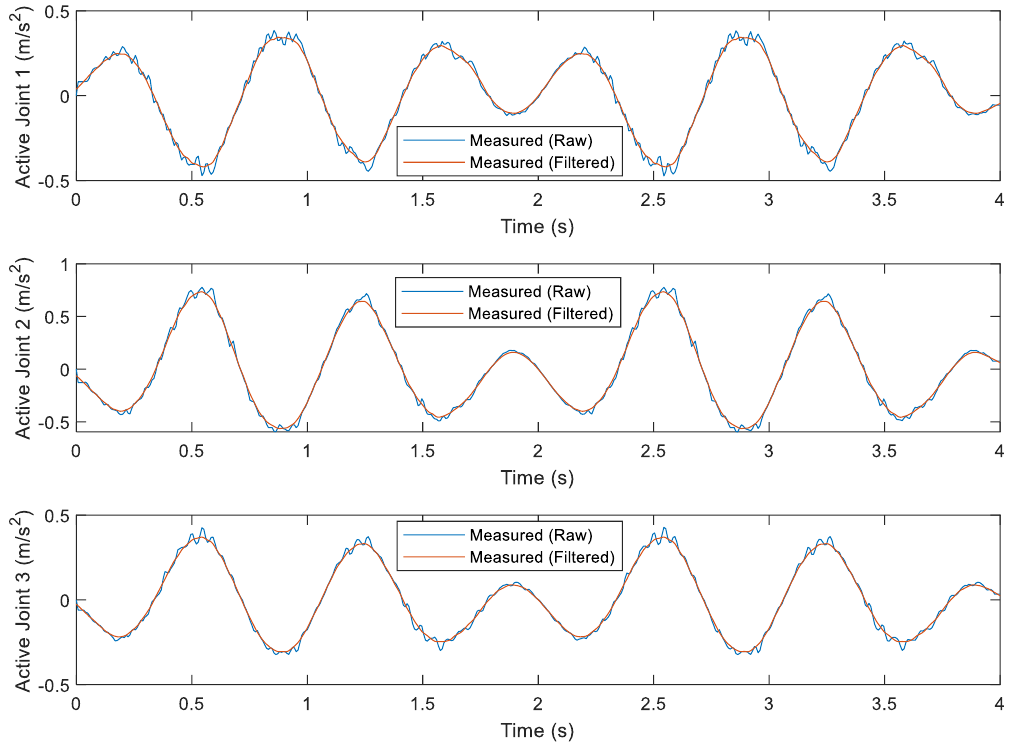
Figure 10. Raw and filtered measured active joint accelerations.